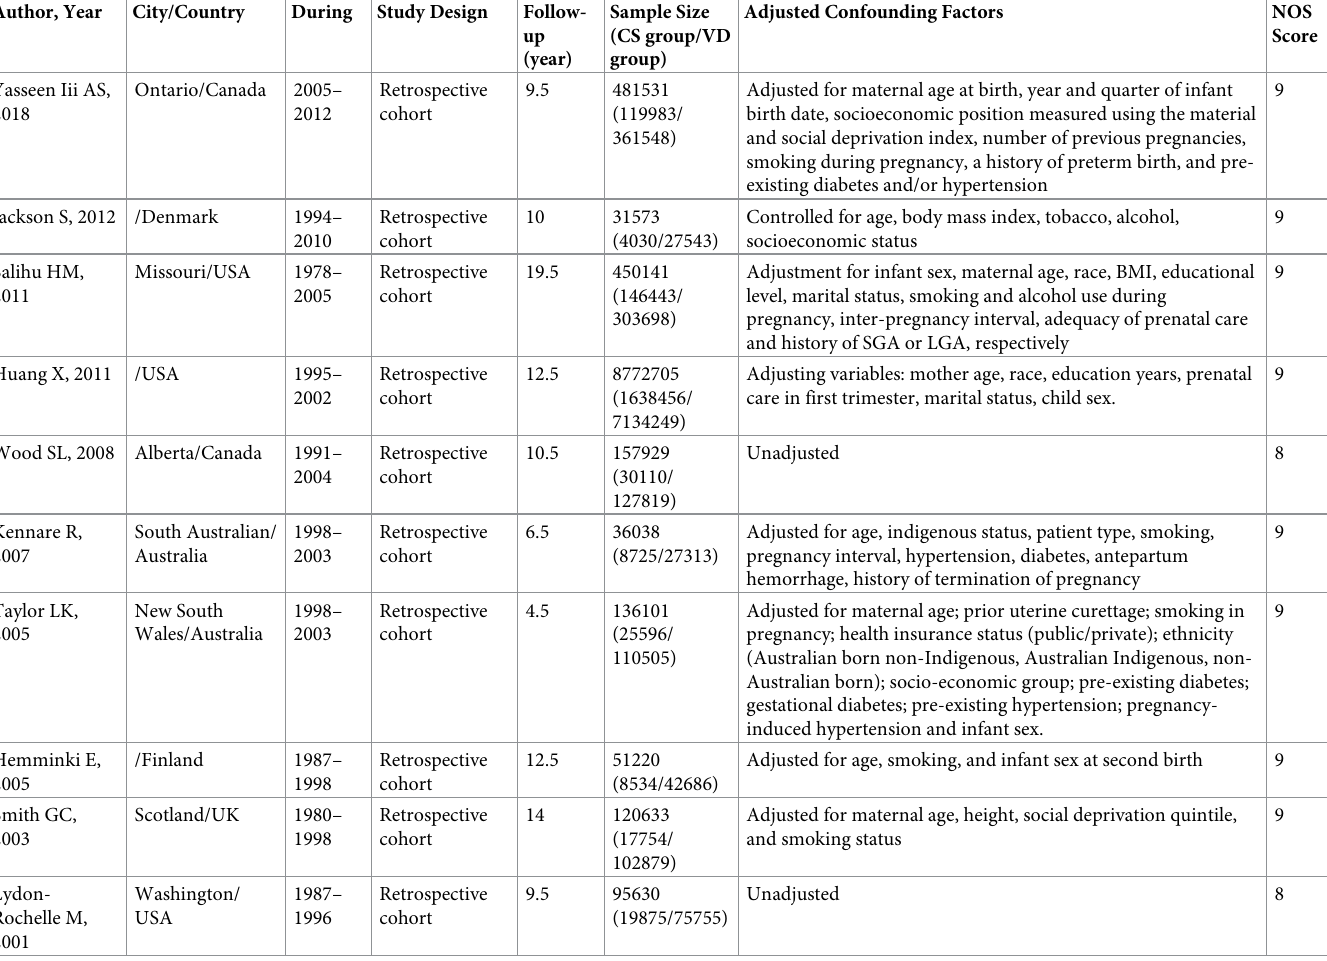
Table 1. Characteristics of the studies included in the